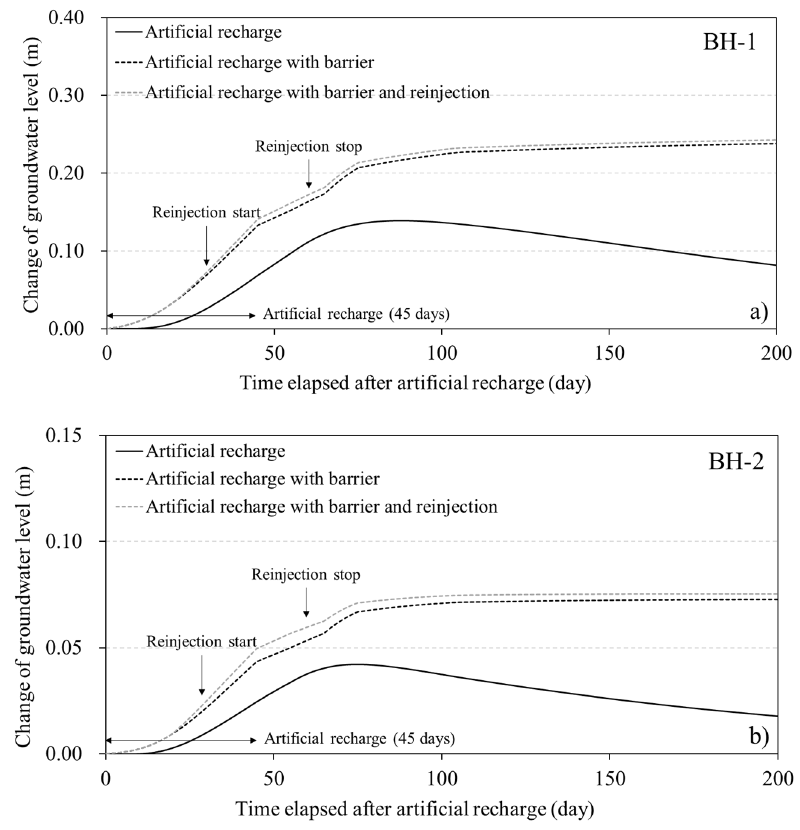
Figure 7. Prediction of groundwater level rise at two monitoring wells after artificial recharge: ( a ) BH-1, ( b ) BH-2.